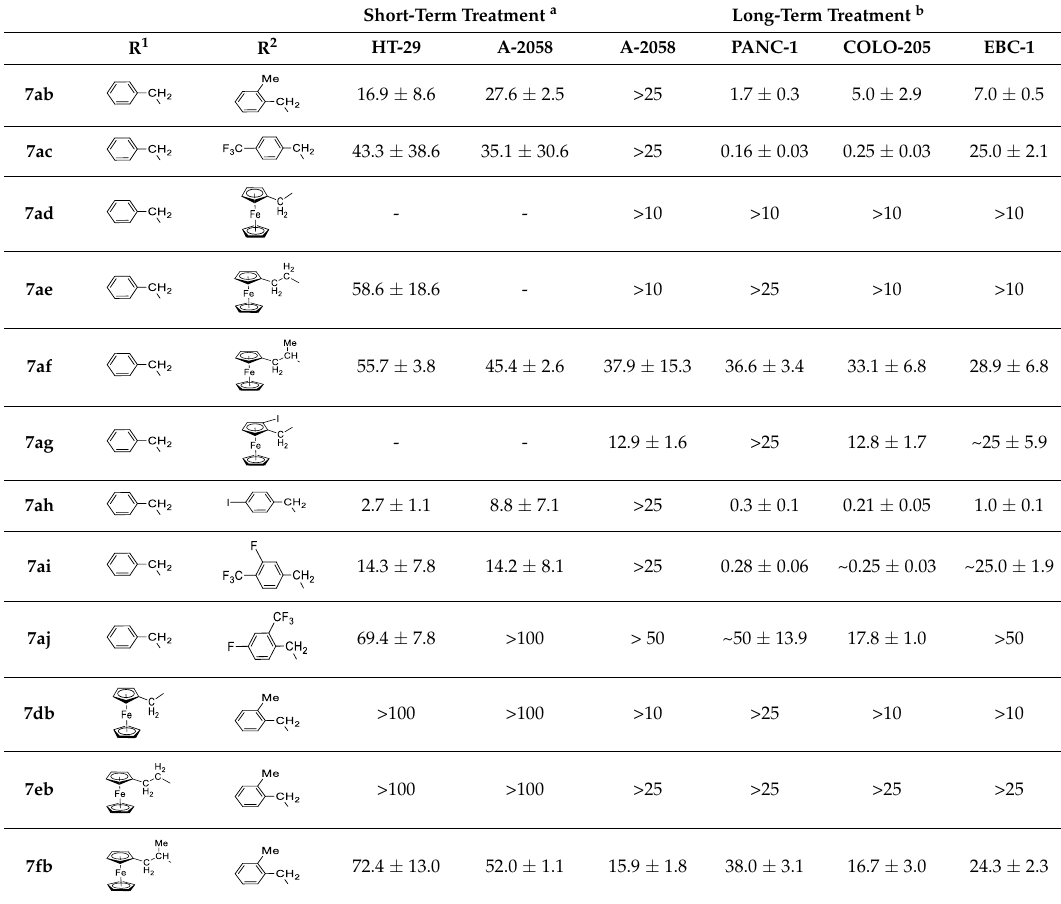
Table 1. In vitro cytotoxic effect of compounds 7ab , 7ac , and novel impiridones on various cell lines characterised by half maximal inhibitory concentration (IC 50 ) ± Standard Deviation (SD) values.